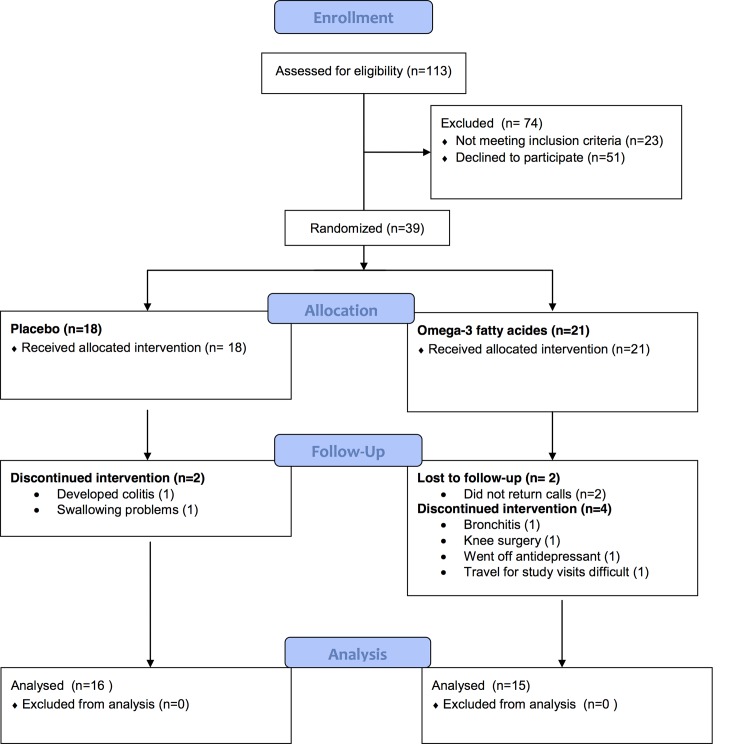
Consort Flow Chart.